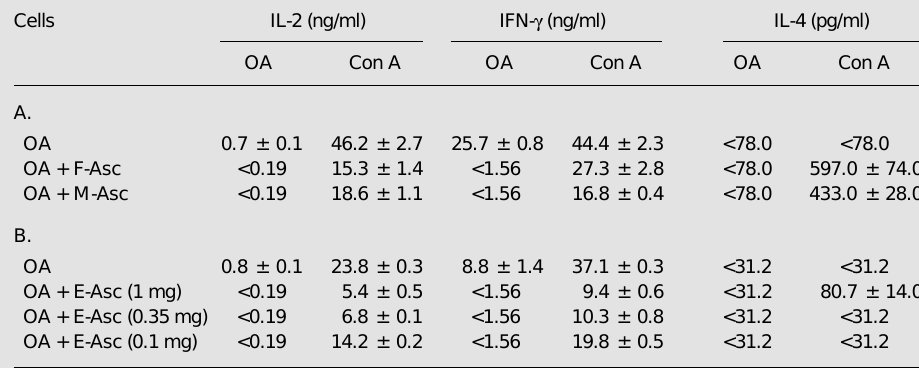
Table 3. Synthesis of IL-2, IFN- g and IL-4 by lymph node cells from mice immunized with ovalbumin (OA) or OA plus female, male or egg extract.